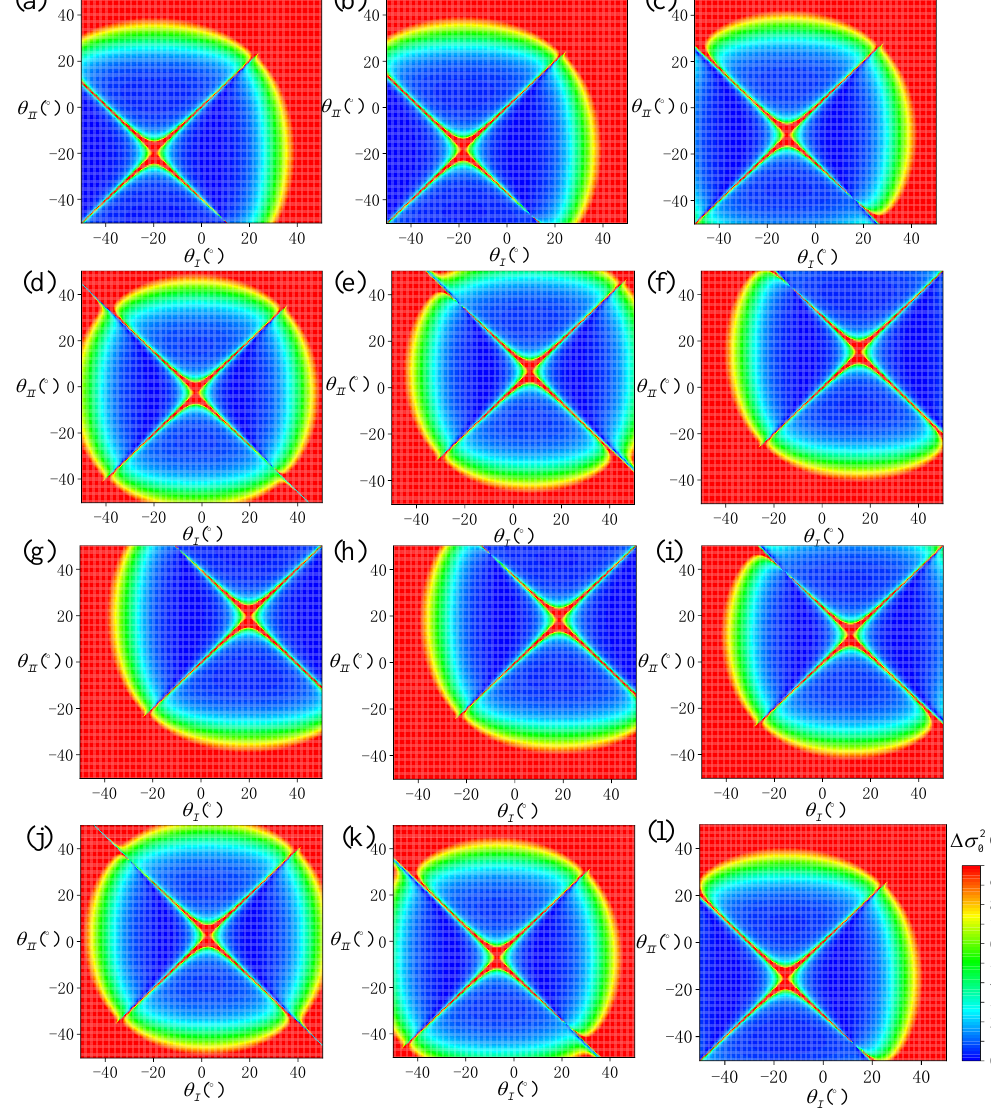
Figure 10. Distribution of SSR estimation error ( ∆𝜎 02 ) simulated under each SVA combination ( 𝜃 𝐼 , 𝜃 𝐼𝐼 ) at different sun azimuth angles: ( a ) 𝜙 0 = 0°, ( b ) 𝜙 0 = 30°, ( c ) 𝜙 0 = 60°, ( d ) 𝜙 0 = 90°, ( e ) 𝜙 0 = 120°, ( f ) 𝜙 0 = 150°, ( g ) 𝜙 0 = 180°, ( h ) 𝜙 0 = 210°, ( i ) 𝜙 0 = 240°, ( j ) 𝜙 0 = 270°, ( k ) 𝜙 0 = 300°, and ( l ) 𝜙 0 = 330°